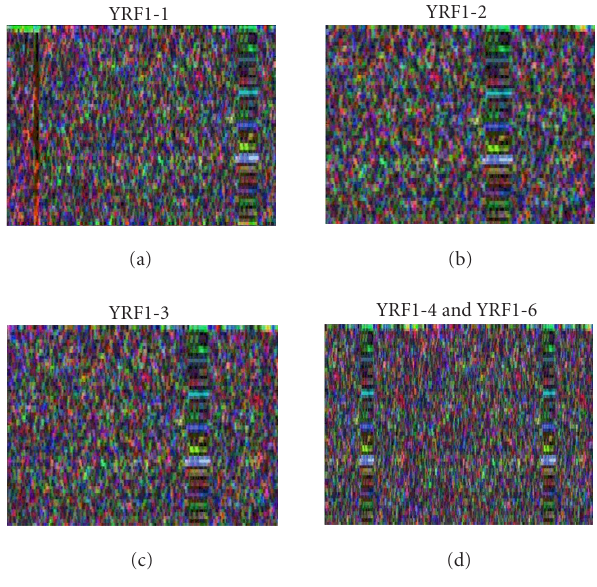
Figure 21: Four spectrograms showing similarity between YRF1 genes 1, 2, 3, 4, and 5. The genes have very similar spectrograms.